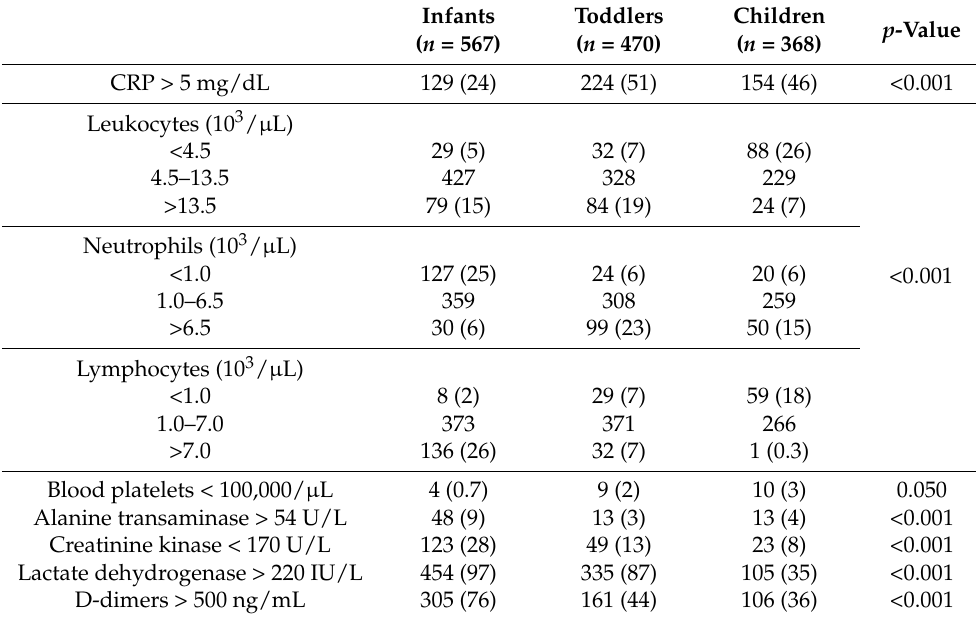
Table 3. Laboratory findings in hospitalized pediatric patients with COVID-19 according to age, based on the chi-square